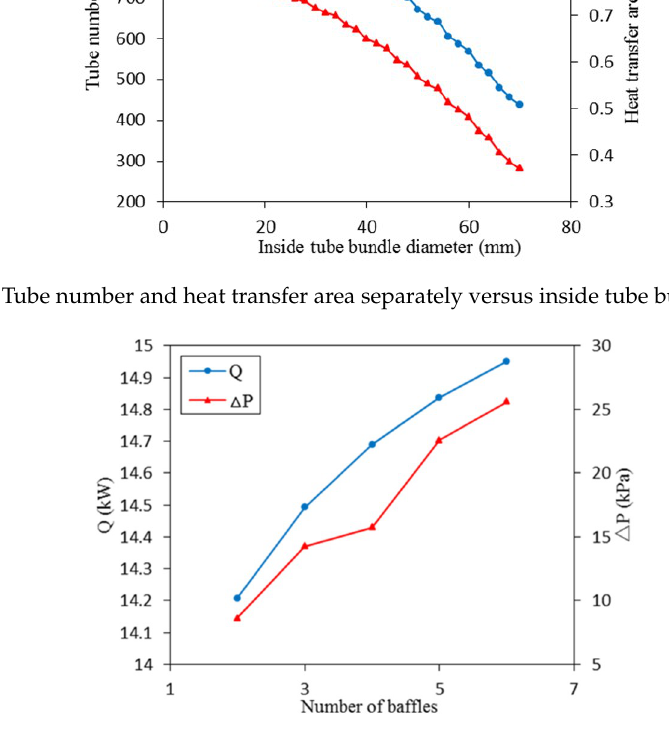
Figure 11. Heat transfer capacity and shell-side pressure drop separately versus tube bundle diameter. Figure 12. Tube number and heat transfer area separately versus tube bundle diameter.